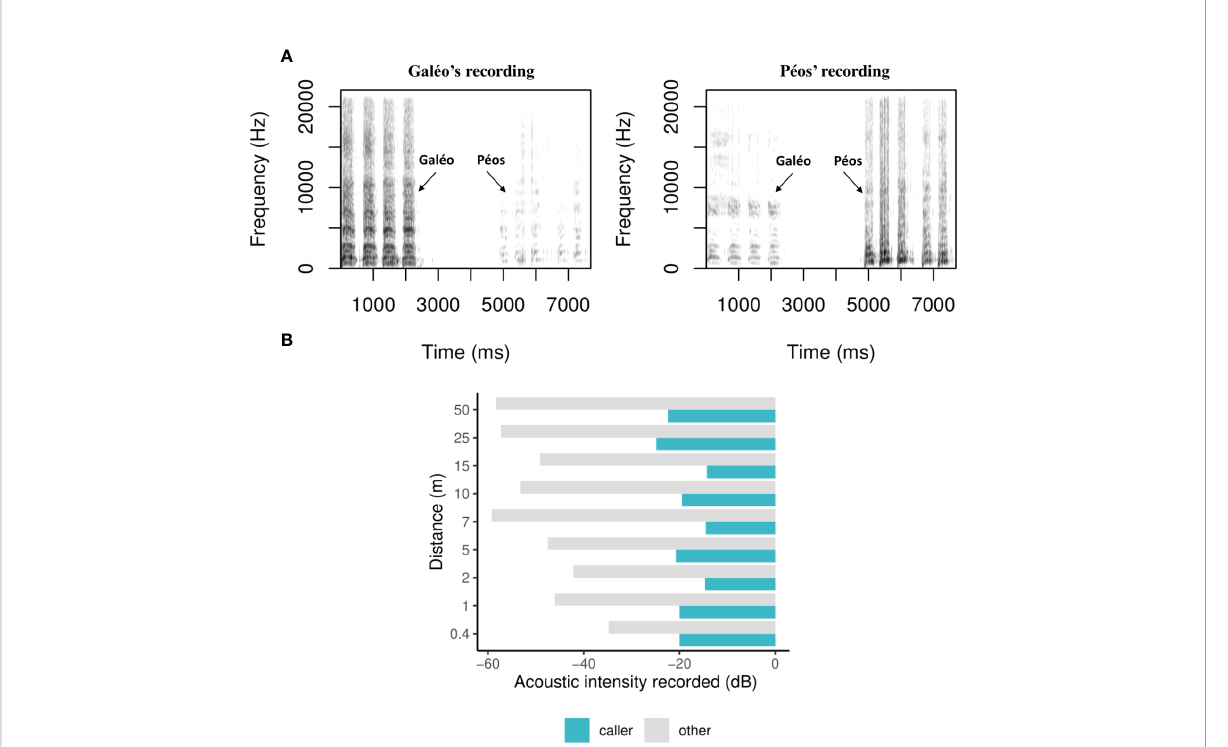
FIGURE 2 First test: (A) Qualitative analyses of spectrograms showed that vocalizations emitted by the tagged individual were always identi fi able and distinguishable from other vocalizations recorded. These two spectrograms were obtained from the tag attached on Gale ́ o (left spectrogram) and Pe ́ os (right spectrogram) while they were at a distance of 0.4m and parallel. When Gale ́ o vocalized, his vocalizations were recorded with higher acoustic intensity in his spectrogram (left) than in Pe ́ os ’ spectrogram (right) and vice versa, when Pe ́ os ’ vocalizations were analyzed. (B) Bar plots showing that the maximum amplitude (in dB) of vocalizations emitted by tagged dolphins (blue bars) were always recorded with higher acoustic intensity across the nine distances